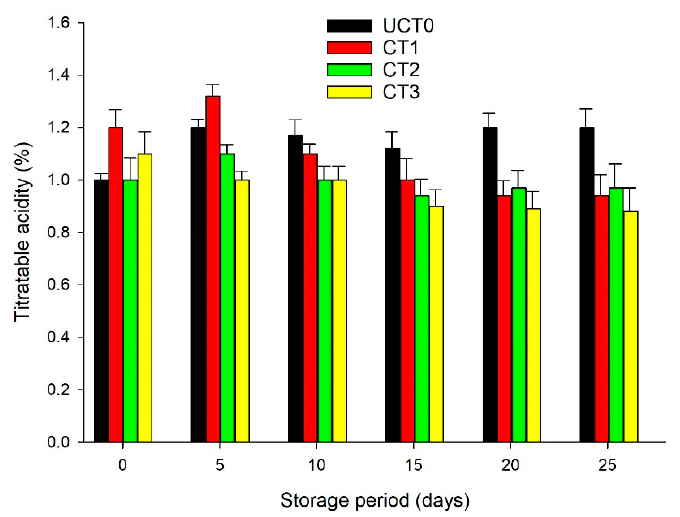
Figure 6. Titratable acidity (%) of Golden Delicious apple slices coated (with CT1, CT2, and CT3), and not treated (UCT0) at day 0, and after 5, 10, 15, 20, and 25-days of storage at 4 °C in dark conditions and 85% relative humidity (RH). Values indicate the means ± standard deviations ( n = 3). Abbreviations: UCT0, uncoated apple slices used as control; CT1, apple slices coated with chitosan- glycerol-cinnamon oil; CT2, apple slices coated with guar gum-glycerol-cinnamon oil; CT3, apple slices coated with composite guar gum-starch-glycerol-cinnamon oil.